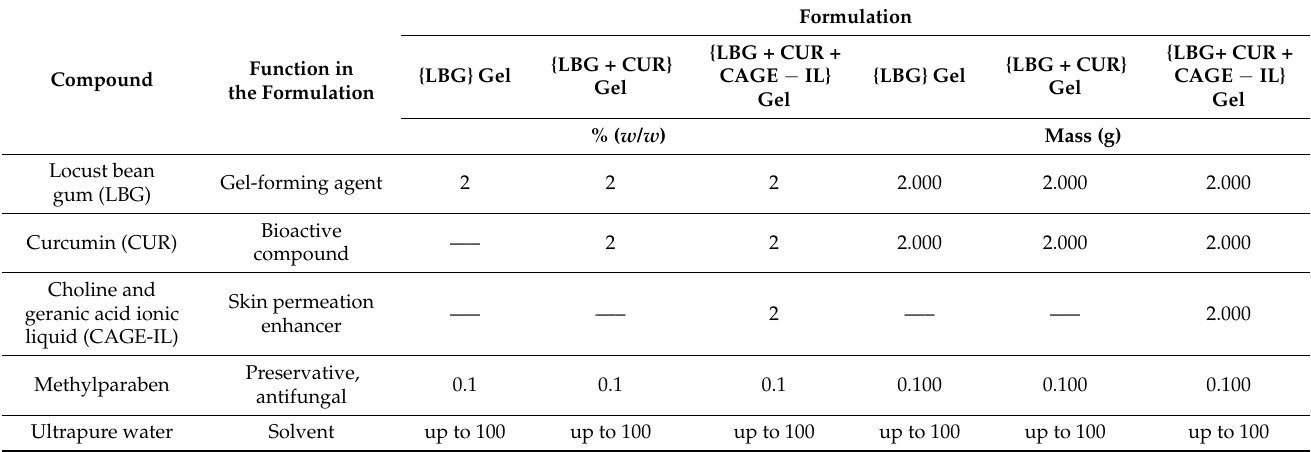
Table 1. Detailed composition of all gel formulations